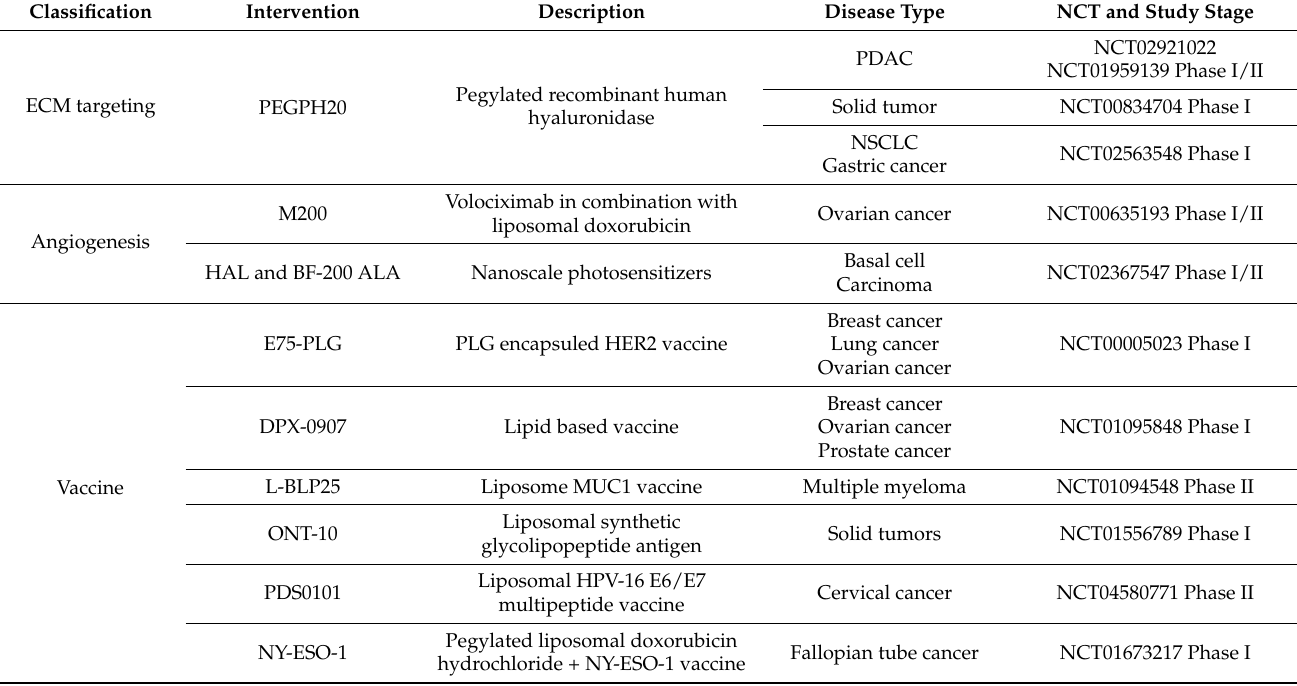
Table 1. Clinical trials of nanoparticles in the treatment of